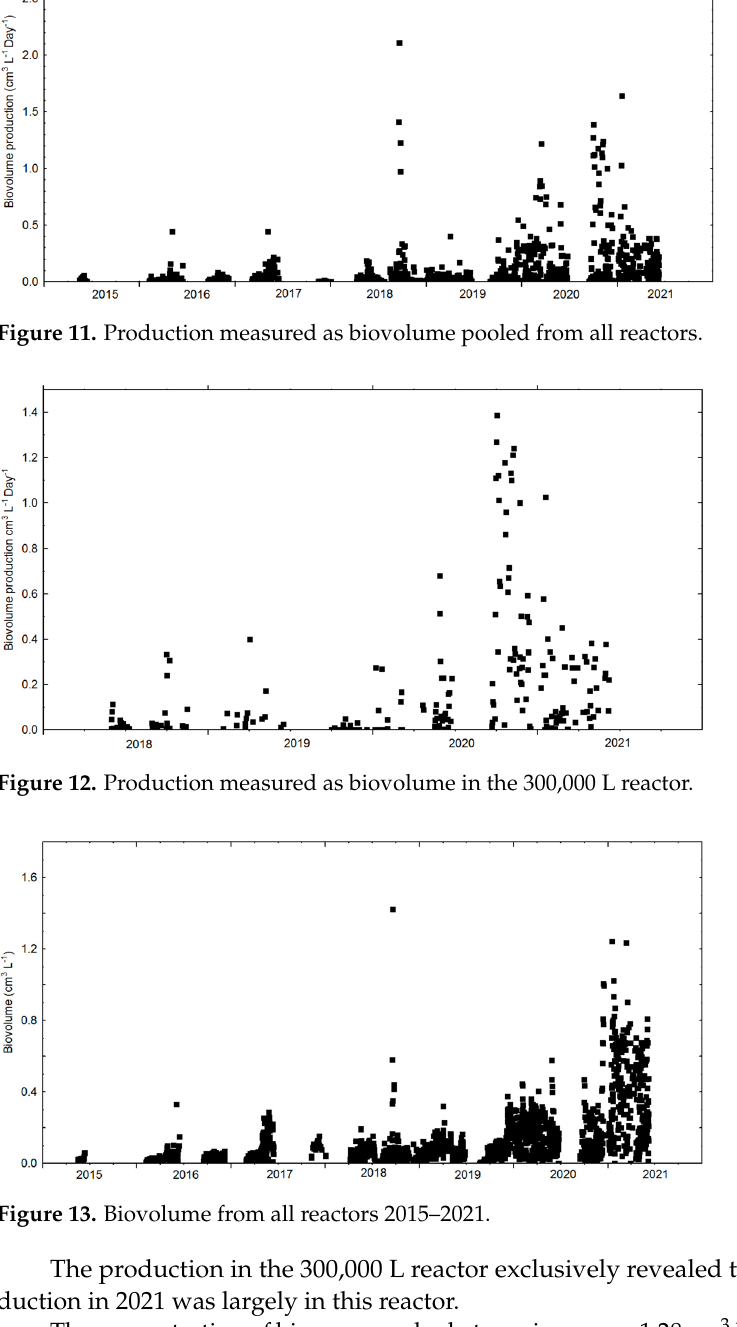
Figure 10. Cell doubling rates from all reactors for the years 2015–2021.